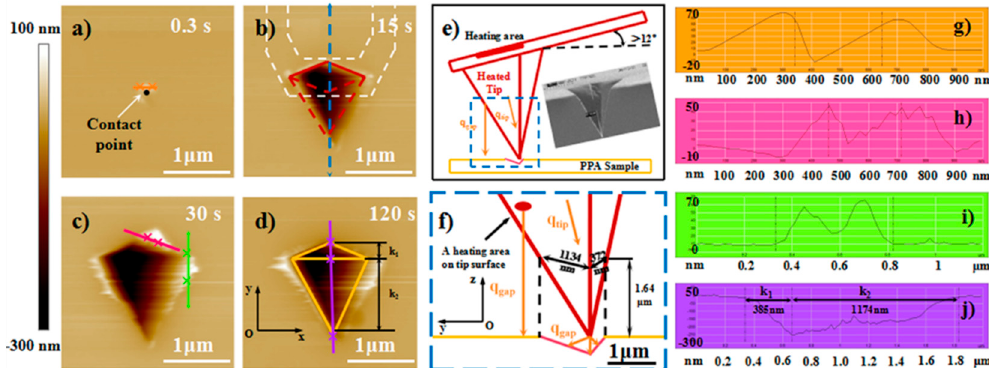
Figure 3. AFM topographic images of the pyramid air gap structures and the cross-section plot of the marked location. The heating times in the topographic images were 0.3 s ( a ), 15 s ( b ), 30 s ( c ), and 120 s ( d ), the tip temperature was kept at 205 ◦ C. The height cross-section plot of the location marked by corresponding color lines are shown in ( g ), ( h ), ( i ) and ( j ), respectively. (a) The white arrow points to the initial tip-sample contact point. (b) The white dashed lines schematically show the cantilever orientation (not to scale). The area enclosed by red dashes is the deviation area of the surface contour away from a symmetric rhombus. ( e ) The cross-section plot along the blue dashed line in (b), showing the accurately geometric shape of the heated tip and the relative position of the cantilever as well as the tip and the air gap structure on the PPA surface. Scanning electron microscope (SEM) image provided by [37] (Reproduced with permission from [37]. Copyright, Springer, 2007). ( f ) Magnified image of the blue dashed frame in (e). The solid red line approximately parallel to the z axis passing through the tip peak shows the projection of the front tip edge at the cross section. The red circular area represents an arbitrary heating area on the heated tip surface few micrometers close to the tip apex. The scale bar is given in the lower right corner.